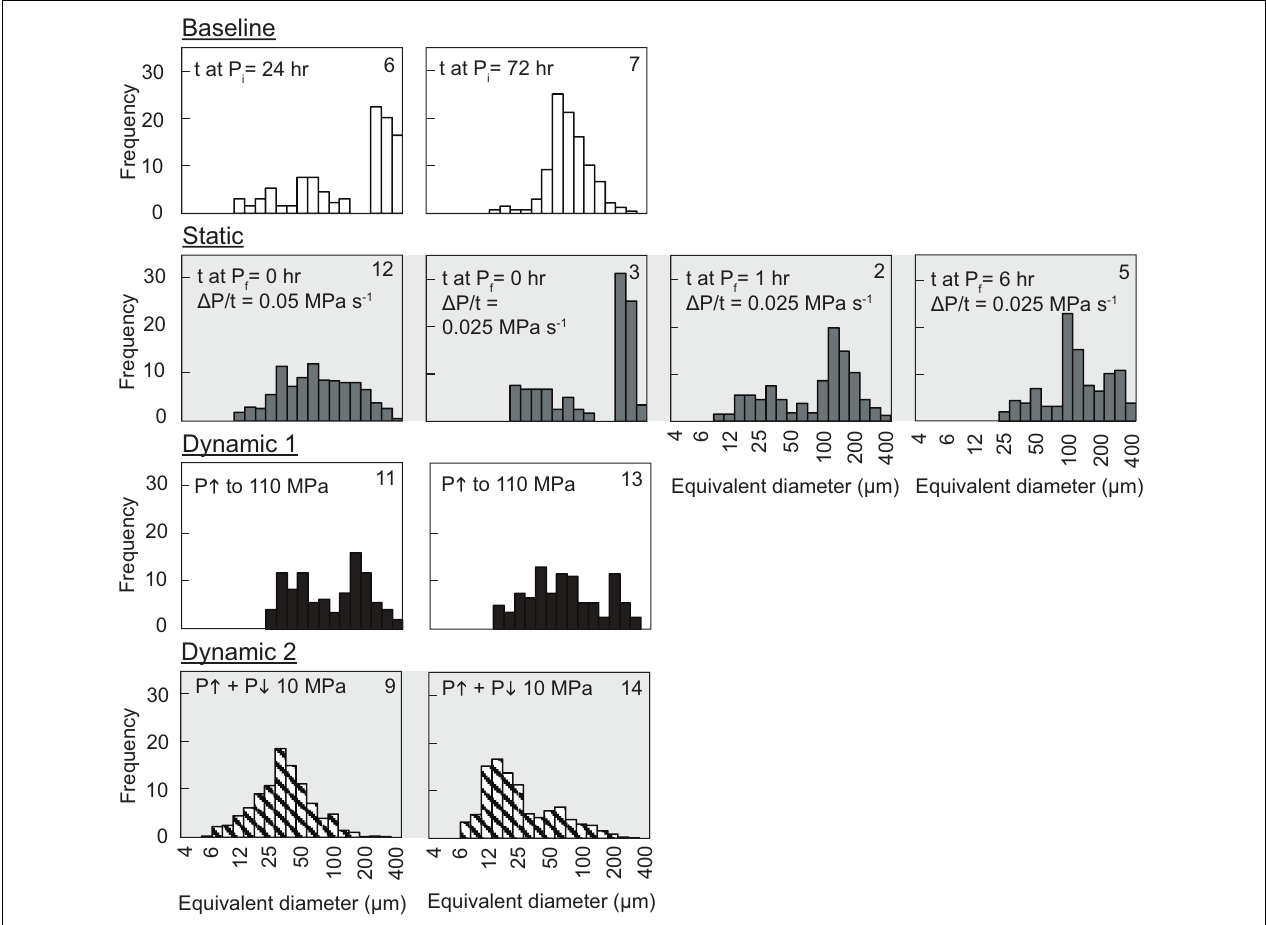
FIGURE 2 | Vesicle size distributions. Sample numbers have been abbreviated and are listed in the right-hand corner of each histogram. Colors of bar graphs correspond to baseline (white), static (gray), D1 (black) and D2 (hatched) experiments. Text in the left-hand corners communicate differences between experiments in the same experimental set. Full detail on experimental conditions are listed in Table 1